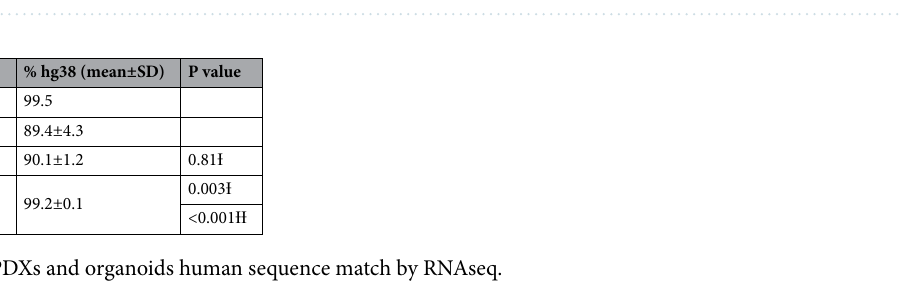
Figure 4. Late passage PDX and organoids upregulate cell cycle and stem cell regulators. ( A ) Upregulated genes in late passage vs. early passage PDX and organoids. ( B , C ) Ingenuity pathway analysis of genes upregulated in late passage ( B ) PDX and ( C ) Top panel: organoids reveals enrichment of cell cycle, stem cell, and cell migration regulators. Bottom panel: Stem cell marker expression in late vs. early PDX and organoids by RNAseq. ( D ) Downregulated genes in late passage vs. early passage PDX and organoids. ( E , F ) Ingenuity pathway analysis of genes downregulated in late passage ( E ) PDX and ( F ) organoids reveals enrichment of cell death, cell adhesion, and differentiation regulators.